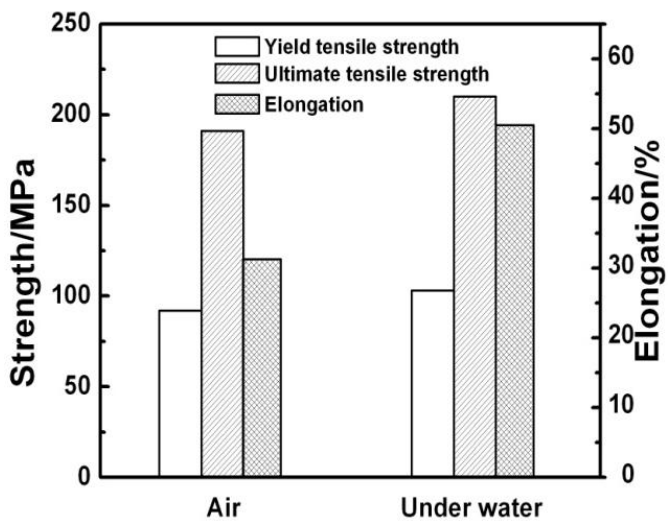
Figure 8. Tensile test result of the FSP AZ31 magnesium alloy processed in air and underwater.